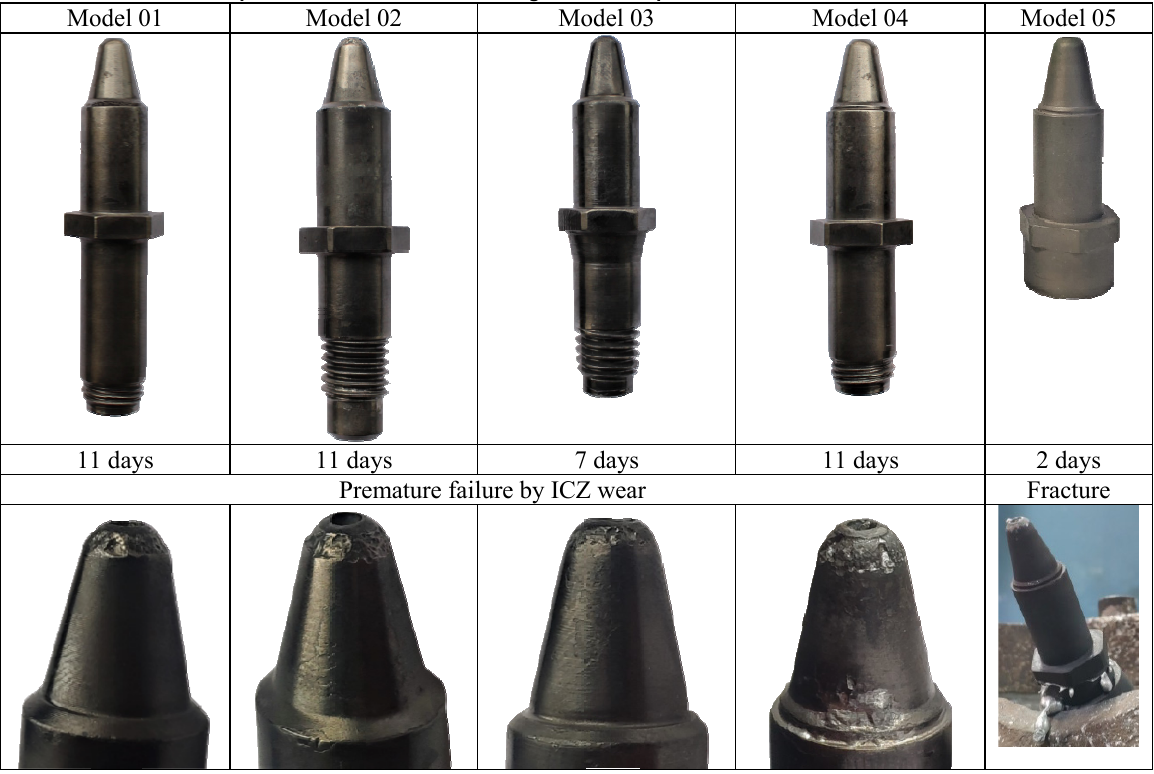
Table 3. ZIN models developed in the first and second stages of development.